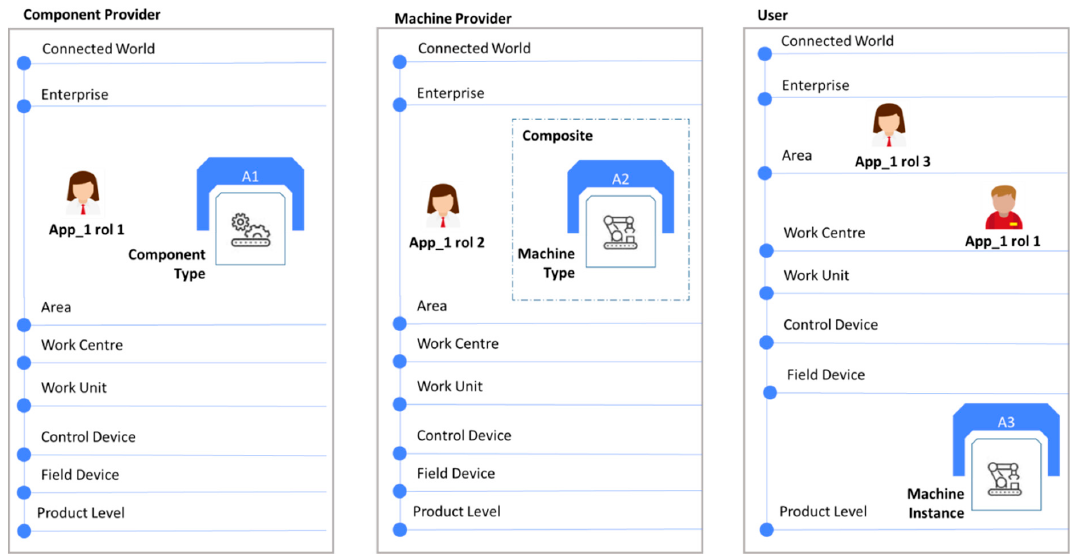
Figure 9. Information flows between RAMI 4.0 hierarchy levels.